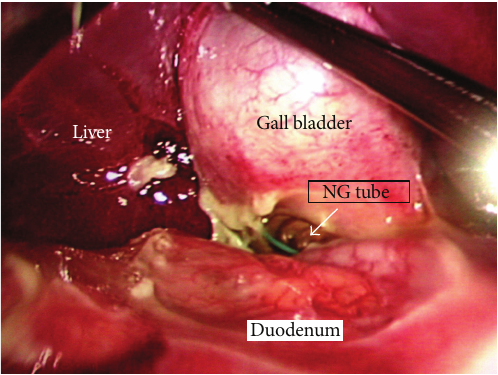
Figure 1: The nasogastric (NG) tube (white arrow) can be seen perforating the duodenum and impacting on the gall bladder.